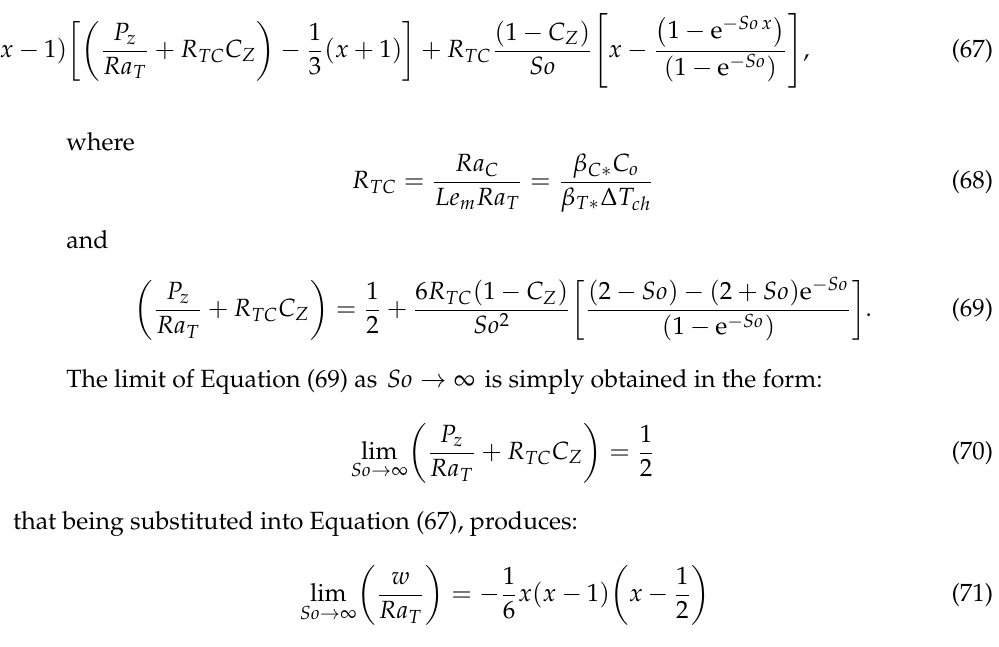
Integrating twice this equation and using the boundary conditions (60) and (61), stating that w = 0 at x = 0 and x = 1 yields a solution in terms of the yet undetermined constant P z . Applying the condition (48) of no flowrate over any cross-section, i.e., w d x = 0 leads to the determination of P and produces the solution for the vertical z velocity in the form: